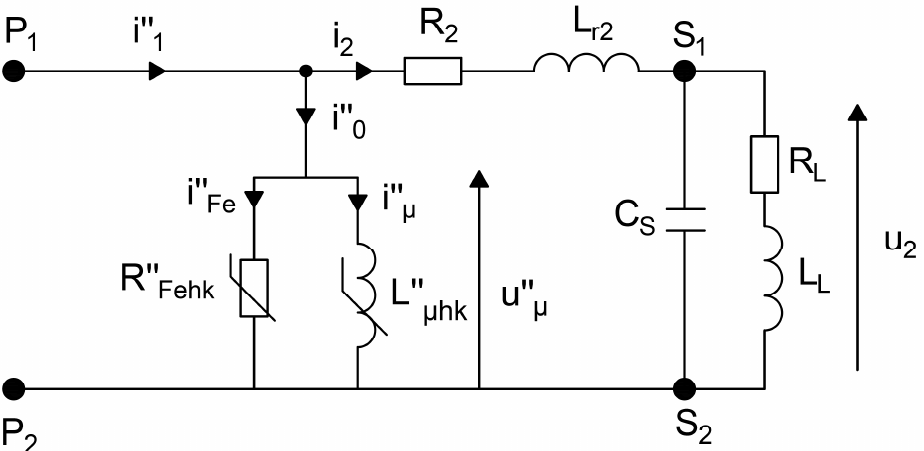
Figure 1. Equivalent circuit of inductive CT for transformation of distorted current. Where: i ″ 1 — instantaneous value of distorted primary current; i 2 —instantaneous value of distorted secondary current; i ″ 0 —instantaneous value of distorted excitation current; i ″ Fe —instantaneous value of distorted current associated with active power losses in the magnetic core; i ″ μ —instantaneous value of distorted magnetization current; u ″ μ —instantaneous value of distorted voltage on the mutual inductance of the windings; u 2 —instantaneous value of distorted secondary voltage; R ″ Fehk — resistance representing the active power losses in the magnetic core; L ″ μ hk —mutual inductance of the windings; R 2 —resistance of the secondary winding; L r2 —leakage inductance of the secondary winding; R L —resistance of the load connected to the secondary winding; L L —inductance of the load con- nected to the secondary winding; C S —capacitance between terminals to the secondary winding; P1/P2—primary winding terminals; S1/S2—secondary winding